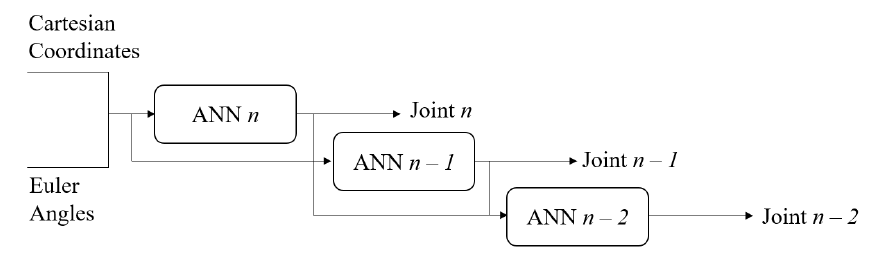
Figure 3. The sequential approach from the robot TCP to the base.